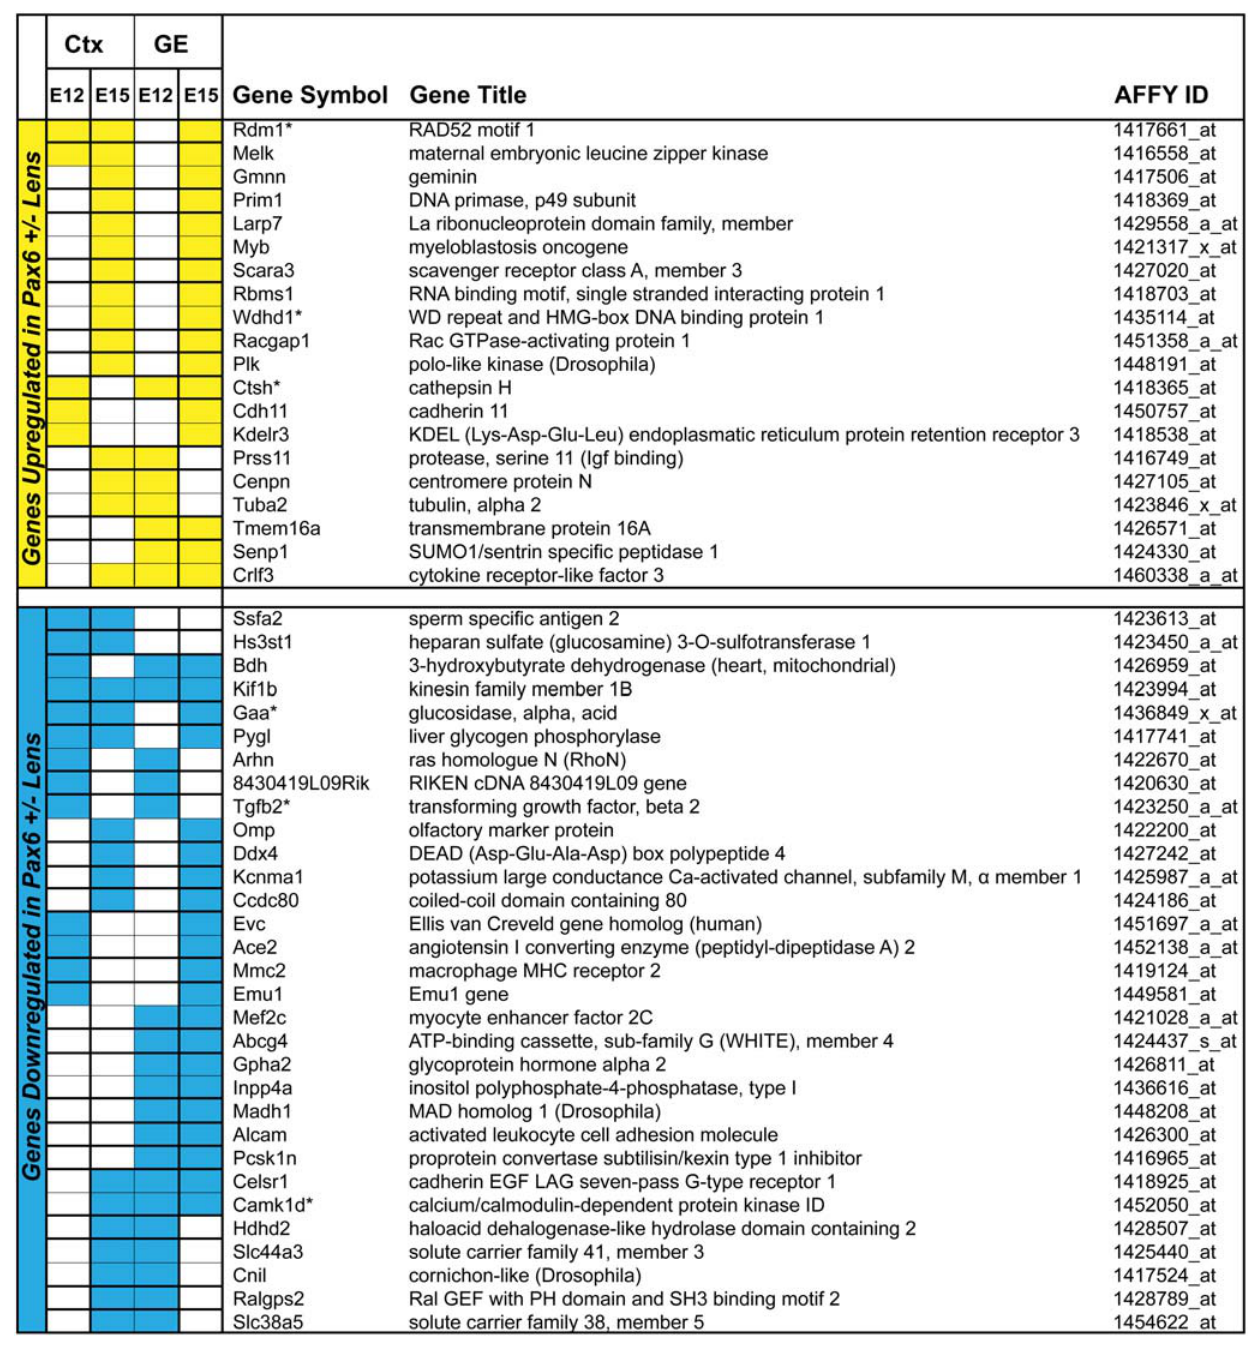
Figure 4. Comparison of differentially expressed genes between mouse lens and embryonic telencephalon. Identification of genes regulated by Pax6 in lens and in at least two regions of the developing telencephalon. Up-regulated (yellow) or down-regulated (blue) genes are grouped together. Differential expression of six genes (marked by asterisk) was validated by qRT-PCR as shown in Fig. 3 (Tgfb2), Fig. S2 (Rdm1, Wdhd1 and Ctsh), and Fig. 3 (Gaa and Camk1d),